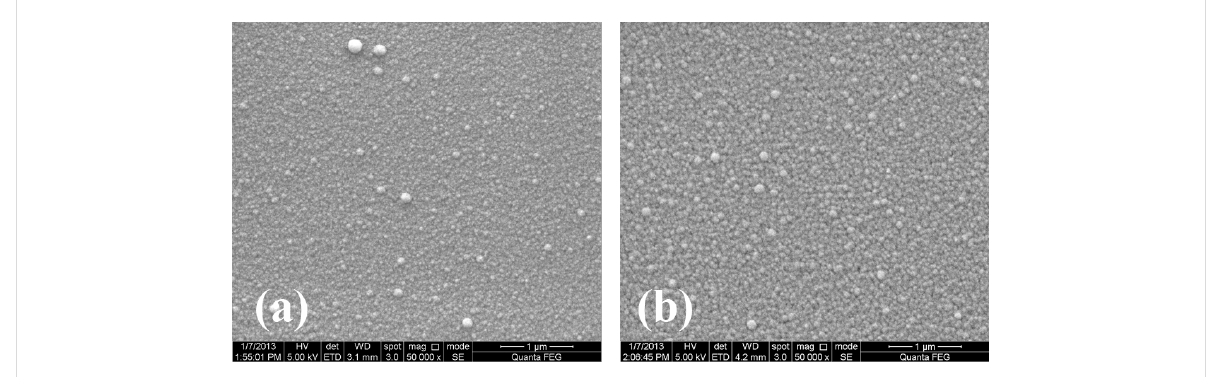
Figure 5: SEM images of titania coating on a) PC, b) PC and PDMS.